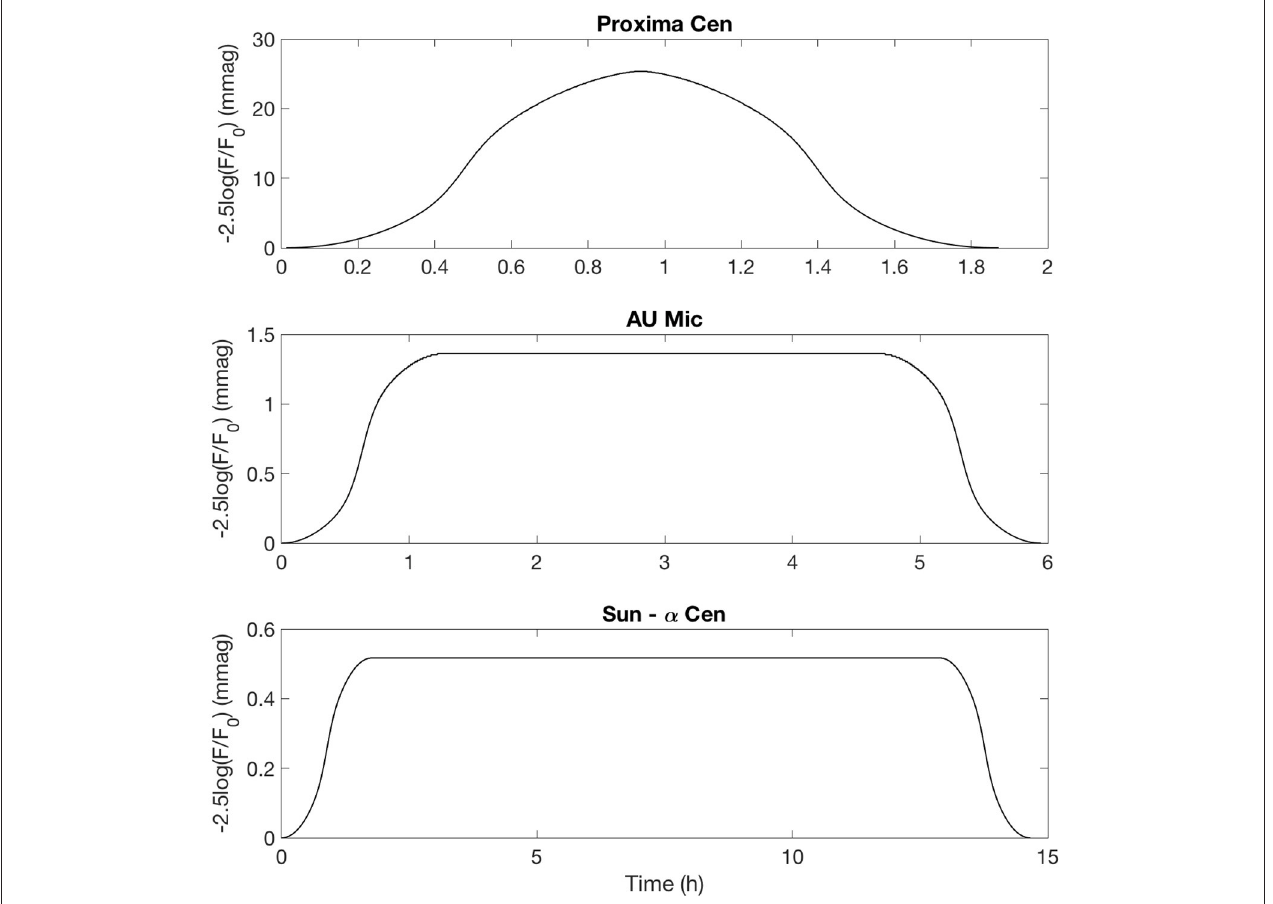
FIGURE 3 | Theoretical Ly α light curves simulating the transit of an Earth-like exoplanet with an extended exosphere, alike the Earth’s one. Calculations were made for the transit of such a planet, orbiting in the habitable zone around an M5V (Proxima Cen), an M0V (AU Mic) and the Sun. For the model, it is assumed that 90% of the transit signal is absorbed by thin interstellar clouds (see Gómez de Castro et al., 2018 for